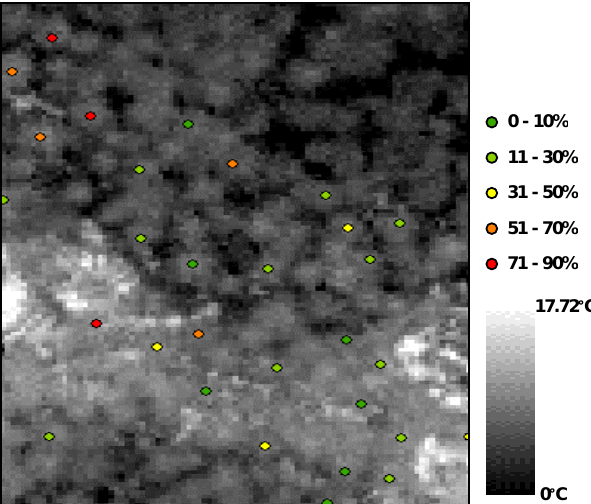
Figure 12. Survey trees distribution with their estimated disease levels, on georeferenced thermal UAV-borne imagery.